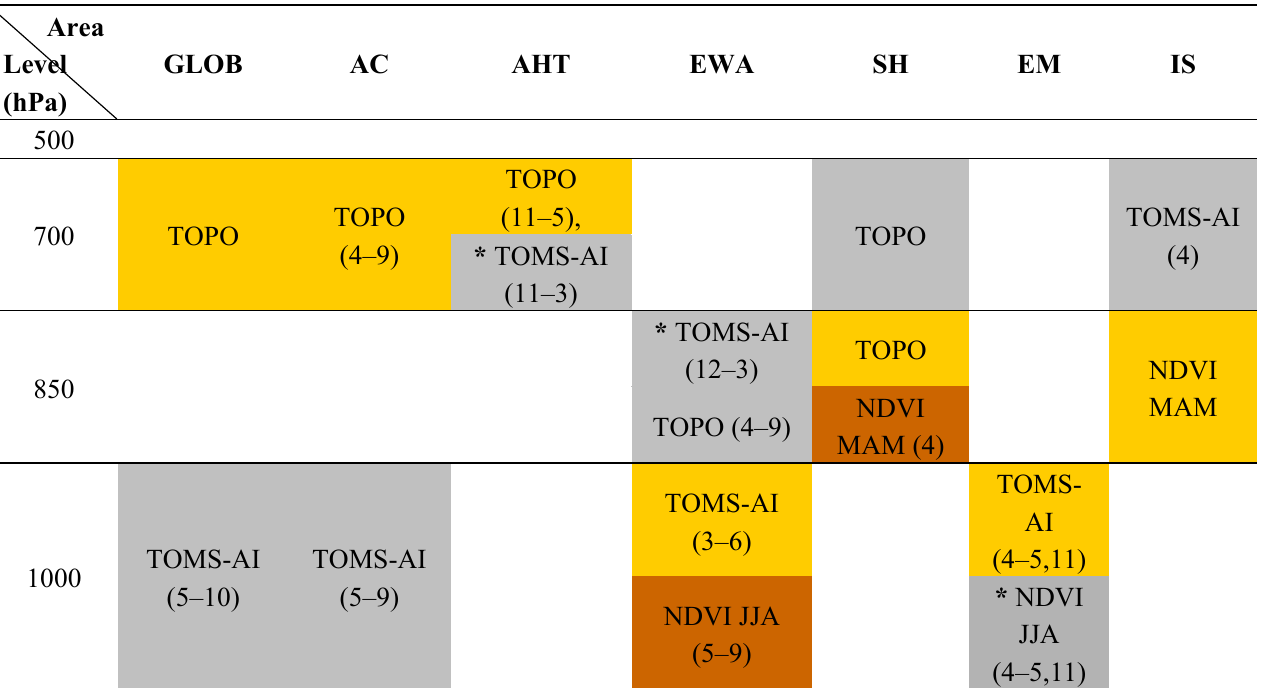
Table 5. The parameter (or factor) prioritization for the GLOB and for each subdomain. The colors represent the three dominant parameters: gold, the most influential parameter; silver, the second; bronze, the third. The months in which these effects are taking place are in